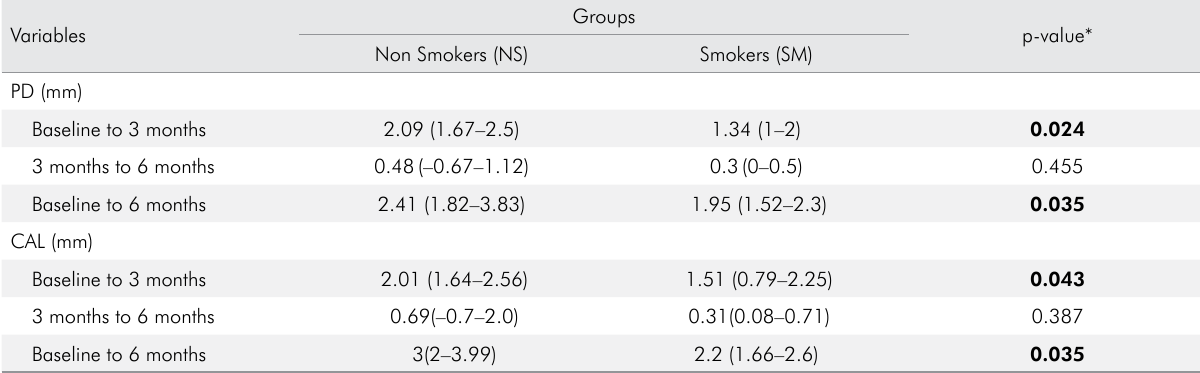
Table 2. Medians (percentile 25-percentile 75) of PD reduction and CAL gain from smokers and non-smokers at three time points of periodontal